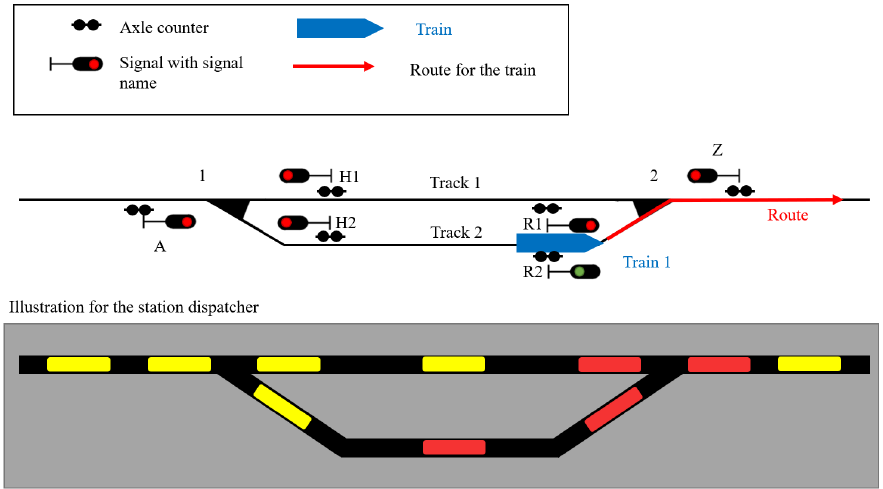
Figure 1. Practical use of axle counters in a railway